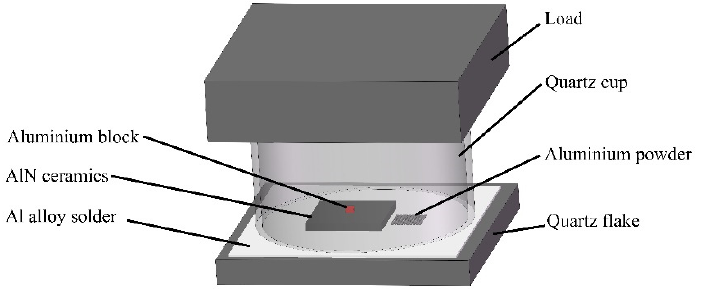
Figure 3. Schematic diagram of the sealed chamber